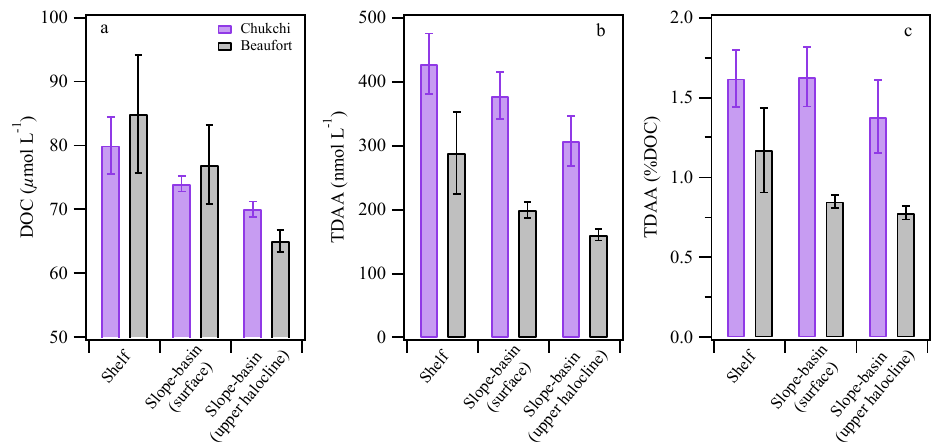
Fig. 6. Spatial variability of average concentrations of (a) dissolved organic carbon (DOC) and (b) total dissolved amino acids (TDAA), and (c) yields of TDAA in shelf, slope, and basin waters of the Chukchi and Beaufort Seas. Error bars represent two times the standard error.